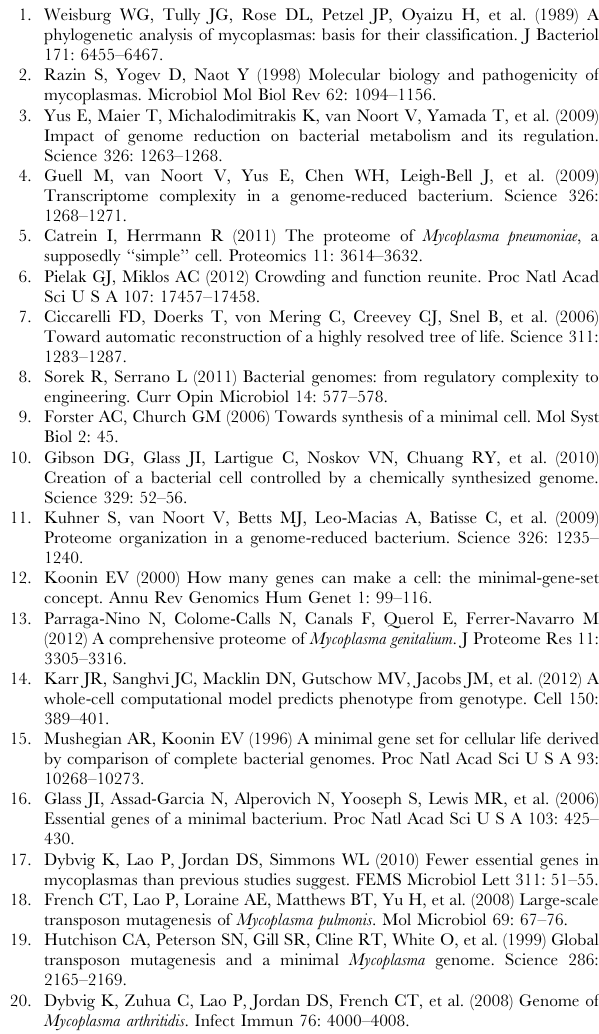
Table S3 Table of putative homologs detected in the selected mycoplasma genomes. The orthologs for the queries either from E. coli or B. subtilis were searched as indicated in Material and Methods in the 39 selected Mollicutes When a hit was found its mnemonic was indicated in the corresponding cell of the table. When there was no homolog, the cell was left empty with a red background. In some cases, the ortholog in a given genome corresponds to a putative pseudogen; it is indicated as ‘‘pseudo’’ in the cell following the mnemonic(s). In some other cases, the Mollicutes gene seems to correspond to a fusion between the gene encoding the given homolog and another entity; it is indicated as ‘‘fusion’’ in the cell following the mnemonic. In some instances, the homolog was not found in the genome from the selected strain but was found in the genome(s) of other strain(s) from the same species; in that case the hit was considered positive and indicated ‘‘found in other strains’’ in the table. Finally, in some genomes that were